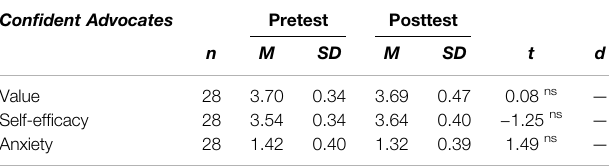
TABLE 5 | Pretest and posttest scores of the con fi dent advocates for the three measures value, self-ef fi cacy and anxiety, and t -test for difference in